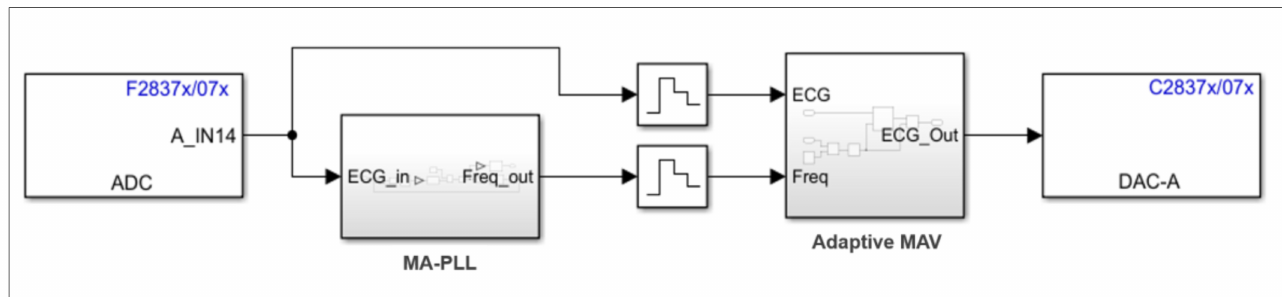
Figure 9. Block diagram of the embedded ECG algorithm.